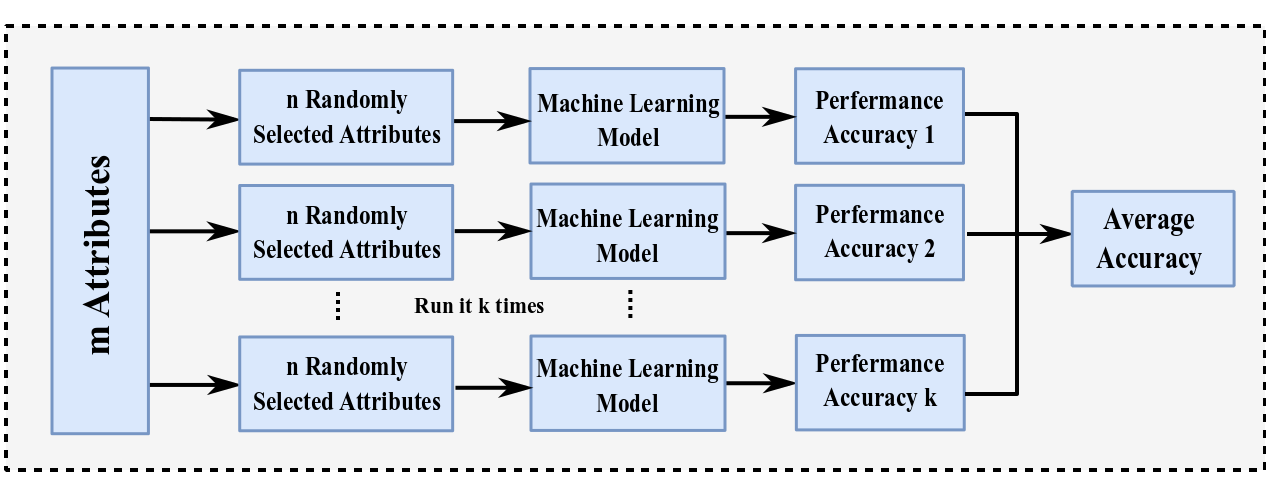
Figure 2. The proposed machine learning framework where we choose m = 16 , n = 4 , and k = 4 in our